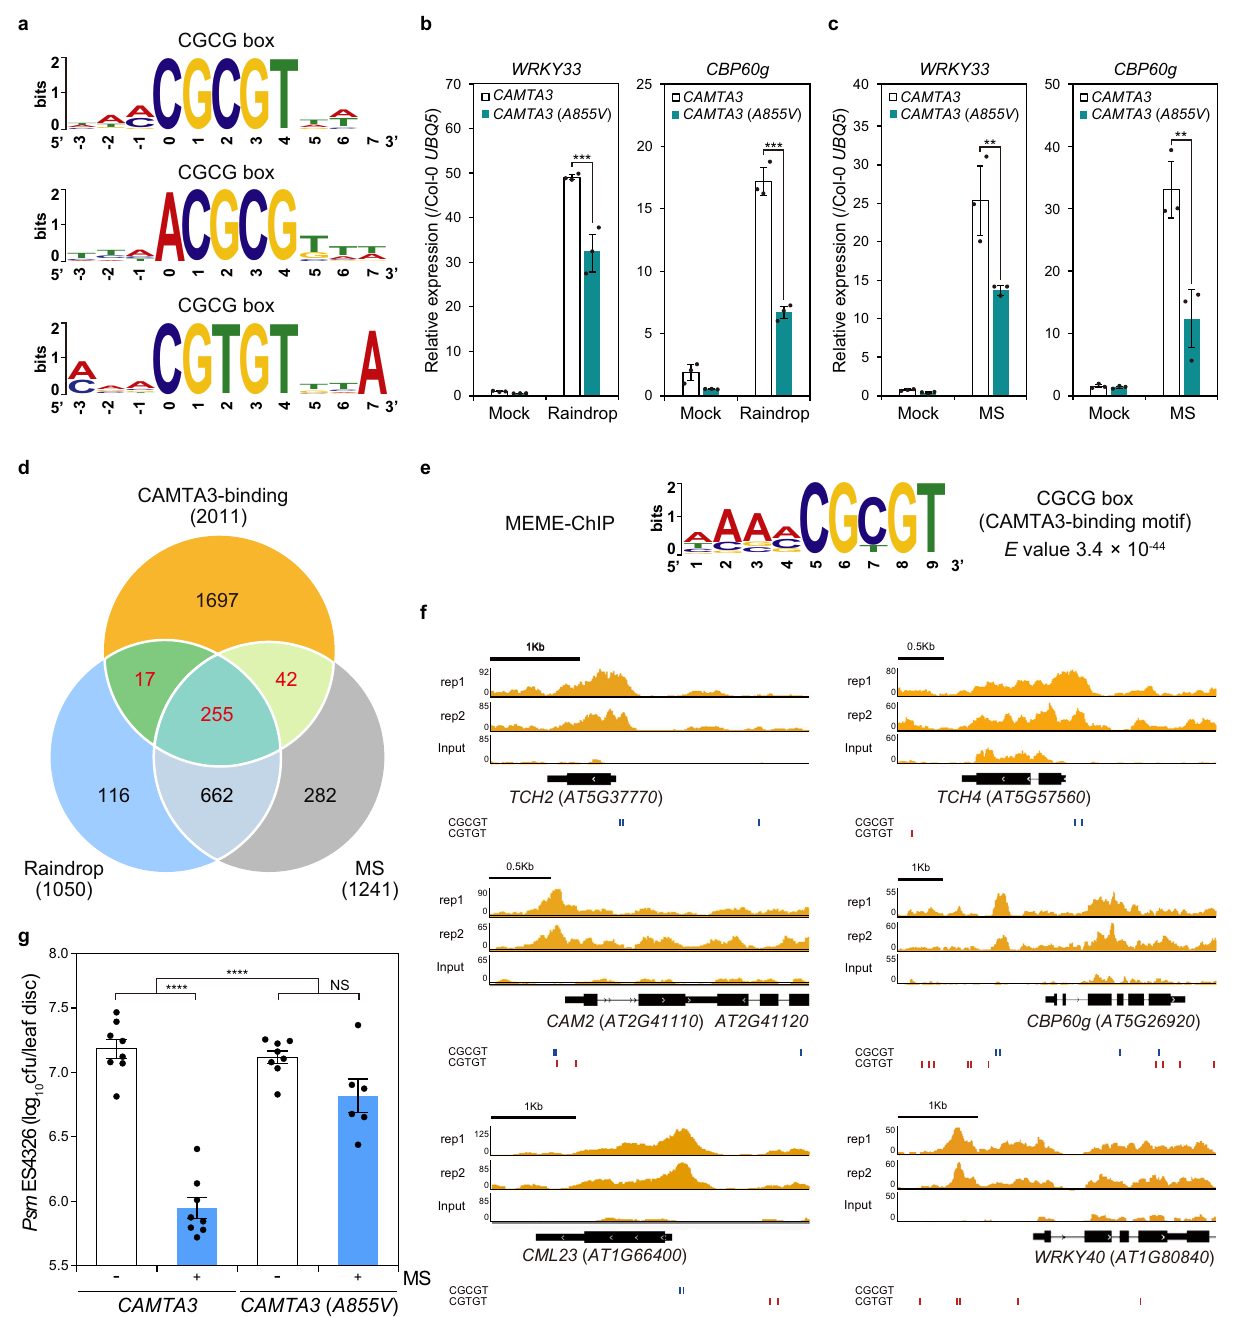
Fig. 3 MS-induced genes are regulated by CAMTA3. a Promoter analysis of the top 300 (among 917 genes) raindrop- and MS-induced genes in terms of expression levels revealed that the CAMTA-binding CGCG box [CGC(/T)GT] was overrepresented among these genes. b , c Transcript levels of WRKY33 and CBP60g in 4-week-old camta2 camta3 CAMTA3pro:CAMTA3-GFP ( CAMTA3 ) and camta2 camta3 CAMTA3pro:CAMTA3 A855V -GFP [ CAMTA3 ( A855V )] plants 15 min after the plants were treated with 1 falling droplet ( b ) or brushed 4 times ( c ), determined by RT-qPCR and normalized to UBQ5 transcript levels in Col-0 Mock. Data are presented as mean ± SD. Asterisks indicate signi fi cant difference (one-sided Tukey ’ s multiple comparison test; ** P < 0.01, *** P < 0.001). n = 6 plants examined over three independent experiments. Each dot indicates a technical replicate. d Venn diagram depicting the overlap between genes with CAMTA3-binding sites in their promoters, as determined by ChIP-seq, and raindrop- and MS-induced genes as determined by RNA- seq. A total of 314 genes, shown in red, were identi fi ed as CAMTA3-target genes. e The CGCG box was identi fi ed as an overrepresented motif among the sequence peaks of 314 genes by MEME-ChIP. f Localization of CAMTA3 on the promoters of the MS-induced genes TCH2 , TCH4 , CAM2 , CBP60g , CML23 , and WRKY40 , as representative of the 314 genes shown in ( d ). Blue and red lines indicate CGCGT and CGTGT, respectively. g Growth of Psm ES4326 in camta2 camta3 CAMTA3pro:CAMTA3-GFP ( CAMTA3 ) and camta2 camta3 CAMTA3pro:CAMTA3 A855V -GFP [ CAMTA3 ( A855V )] plants 2 days after inoculation with ( + ) or without ( − ) MS (4 brushing) pretreatment. Error bars represent SE. Asterisks indicate a signi fi cant difference (one-sided Tukey ’ s multiple comparison test and two-way ANOVA; **** P < 0.0001). Cfu colony-forming units, NS not signi fi cant. CAMTA3 ( − , + ), CAMTA3 ( A855V ) ( − ): n = 8, CAMTA3 ( A855V ) ( + ): n = 6 samples examined over three independent experiments. Each dot indicates a biological